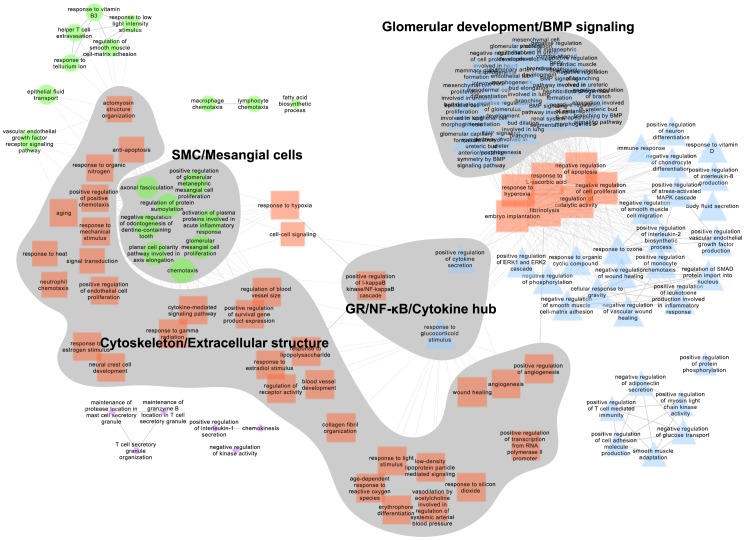
GO.BP functional annotation co-expression network of Dex effects.The GO.BP annotation network was analyzed by FUNNET and visualized by Cytoscape using the most significantly changed genes (>2 fold, q<0.01) from the gene list D.Dex-D.Veh. The different shapes and colors of the nodes represent membership of distinct network modules identified by FUNNET analysis. The size of node correlates with the functional centrality of the network. GO.BP terms are labeled on the node. Solid line, intra-modular link; dashed line, inter-modular link. Shading marks interesting portions of the network that correlate with specific functions.